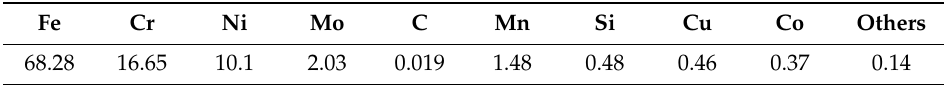
Composition of 316L stainless steel purchased from the company Metals Samples (weight